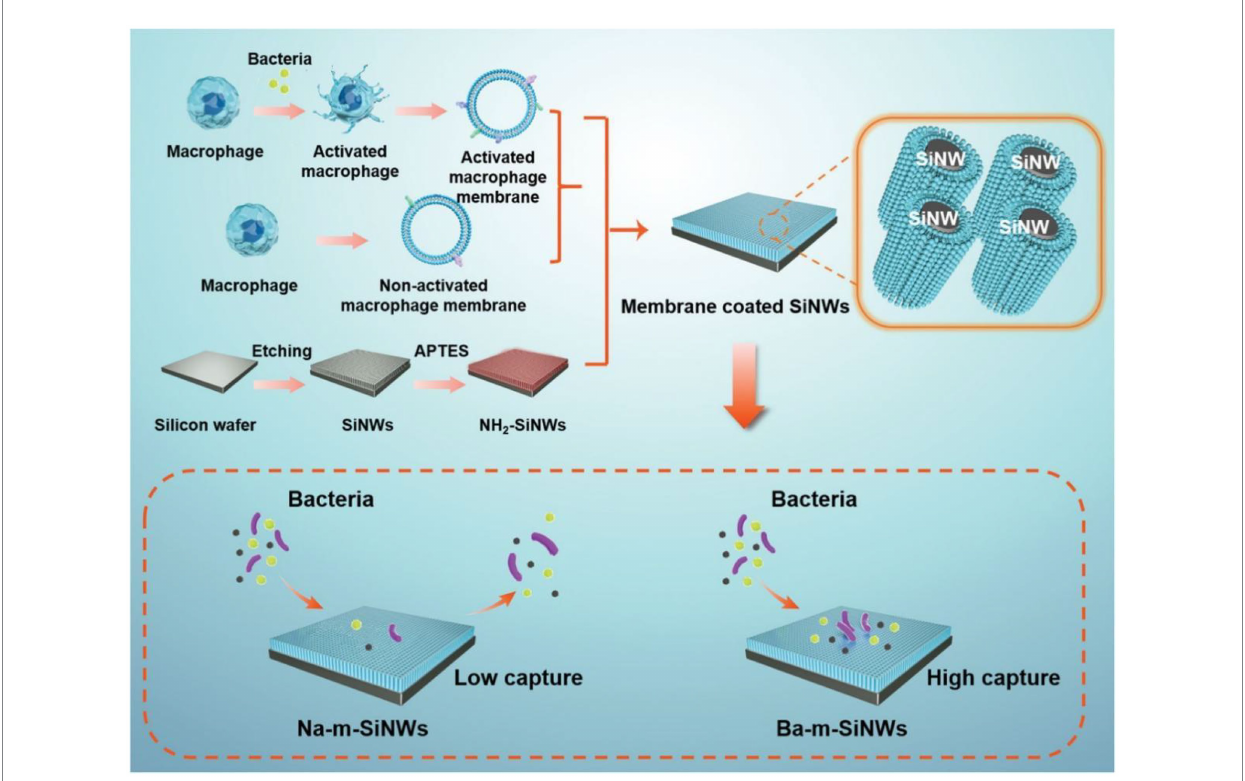
FIGURE 3 Schematic illustration of the preparation process of Na-m-SiNWs and Ba-m-SiNW. Ba-m-SiNWs exhibit more enhanced pathogen capture than Na-m- SiNWs. Reproduced with permission (Liu S. et al., 2021; Copyright© 2021, Wiley-VCH). Na-m-SiNWs, silicon nanowires coated by nonactivated macrophage membranes; Ba-m-SiNWs, silicon nanowires coated by bacterially activated macrophage